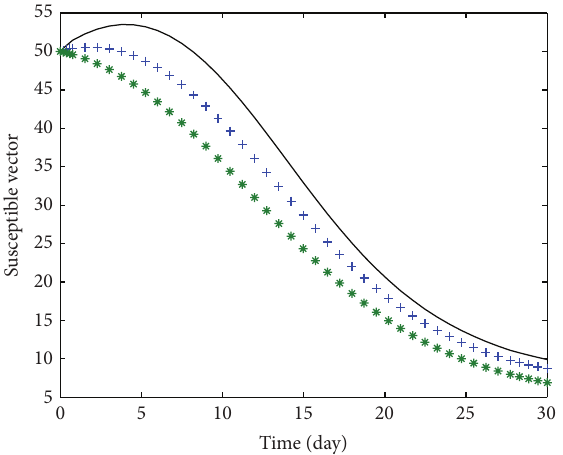
Figure 9: Susceptible vector: solid line 𝛼 = 1.0 , ++ line (𝛼 = 0.95) , and ∗∗ line (𝛼 = 0.90) .